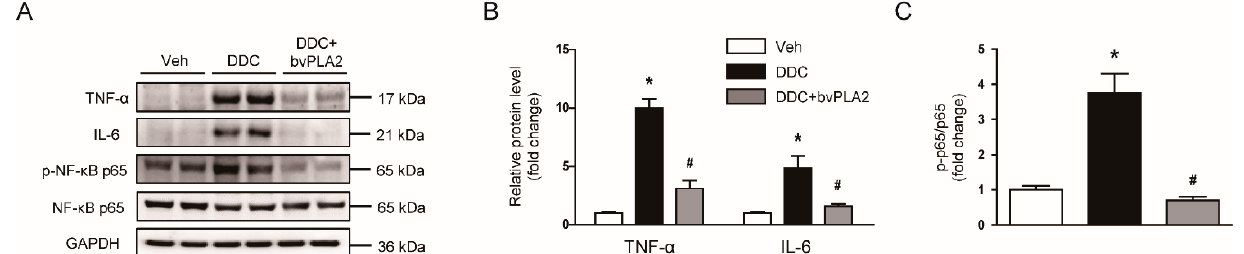
Figure 6. Effect of bvPLA2 on cytokine production and nuclear factor- κ B (NF- κ B) signaling pathway in DDC diet-fed mice. ( A ) Western blotting of tumor necrosis factor- α (TNF- α ), interleukin-6 (IL-6), and p-nuclear factor- κ B (NF- κ B) p65 in liver tissues. ( B ) Quantification of western blots for TNF- α and IL-6. ( C ) Quantification of western blot for p-NF- κ B p65. n = 8 per group. * p < 0.05 vs. Veh. # p < 0.05 vs. DDC.